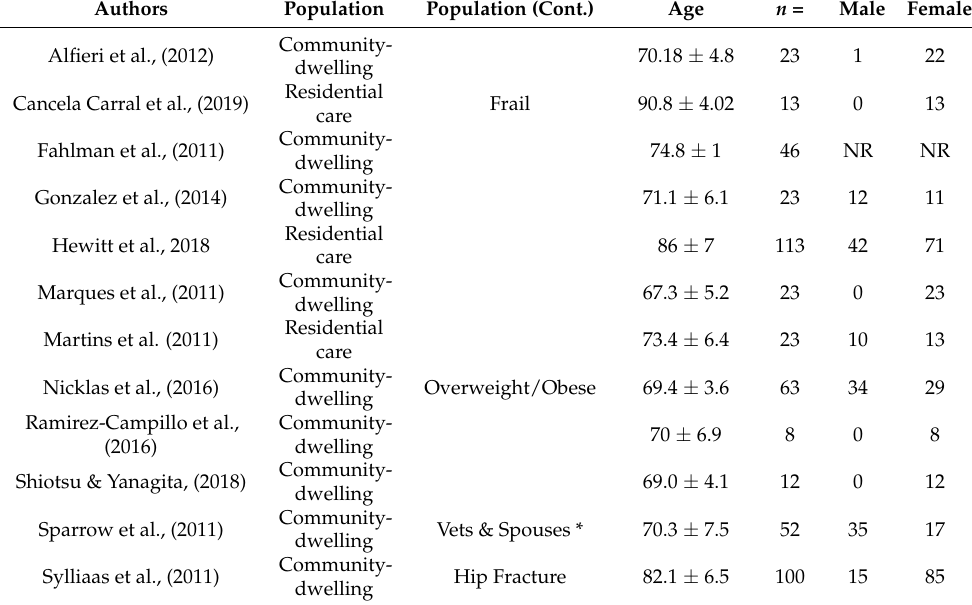
Table 2. Participant